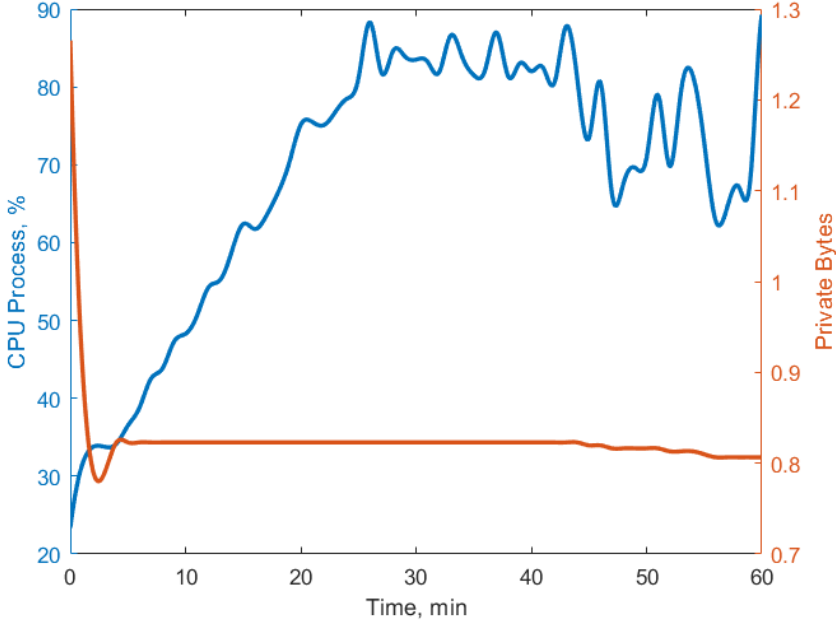
Figure 13. Computational performance, when 10 GB data stream was produced.